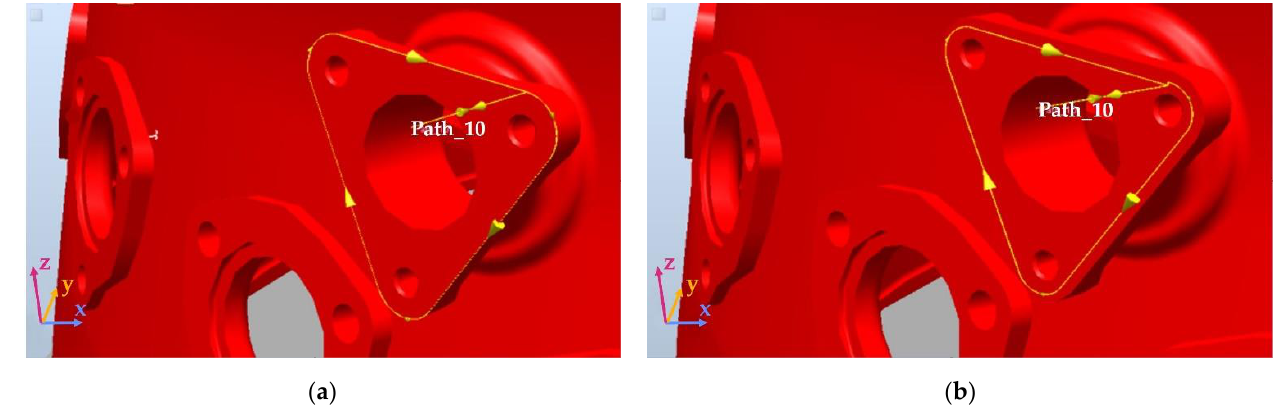
Figure 4. Model of the machining process in RobotStudio: ( a ) nominal trajectory; ( b ) offset trajectory.